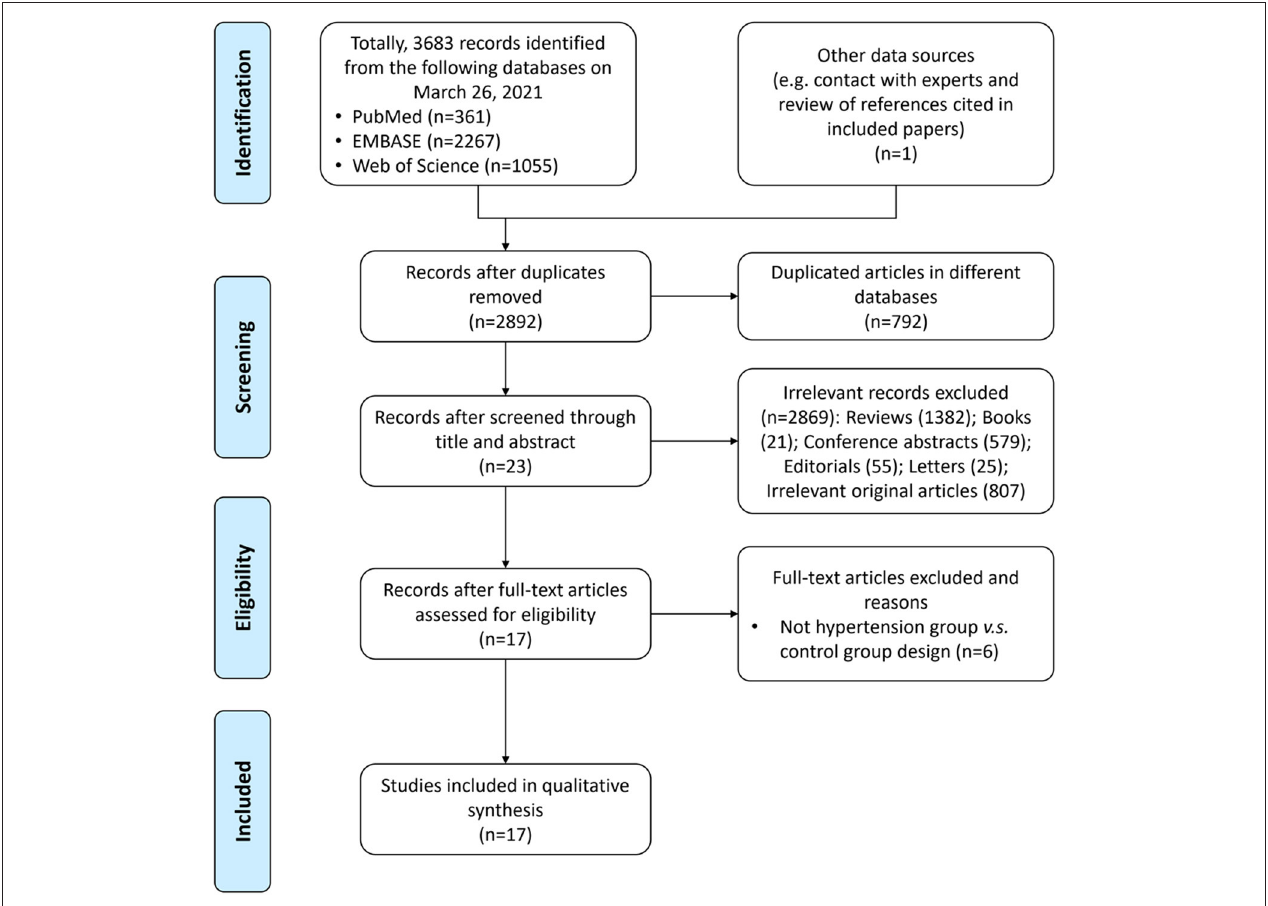
FIGURE 1 | PRISMA flow diagram for study